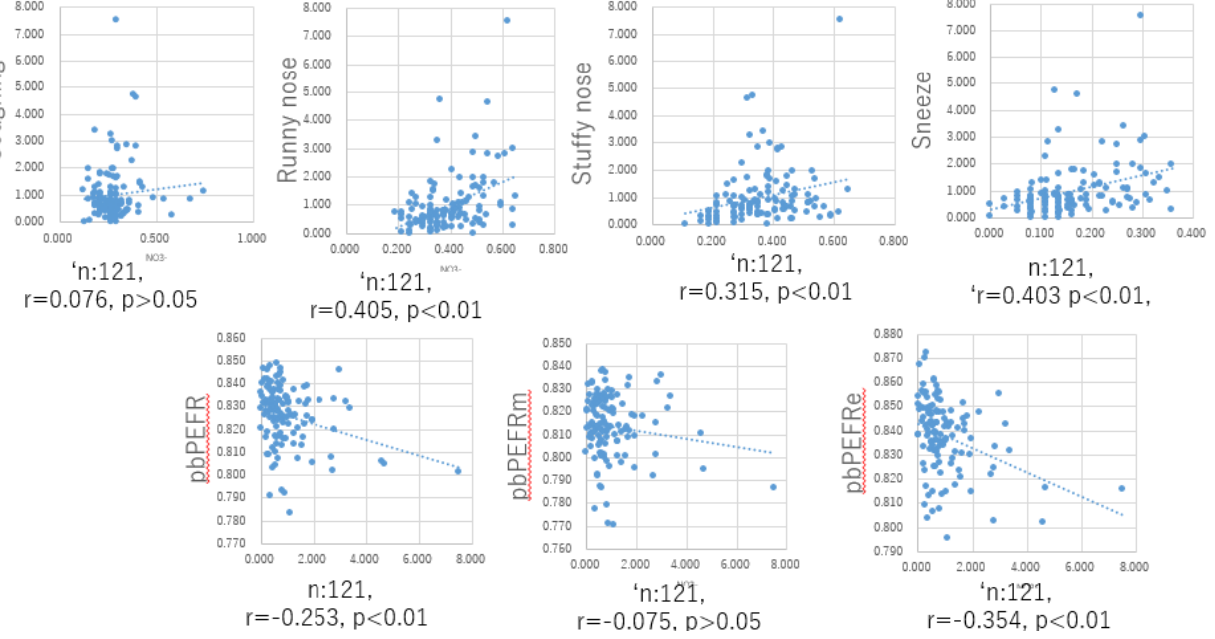
Figure 1. Scatter plot of the relationship between NO 3 − and respiratory symptoms or ratio of daily Peak Expiratory Flow Rate to personal best Peak Expiratory Flow Rate(pbPEFR), in daily mean(pbPEFR), in morning(pbPEFRm), and in the evening(pbPEFRe). Vertical axes show the number of symptoms per day in the total number of partici- pants, and horizontal axes show the daily ion concentration of NO 3- in gm −3 . Numbers are logarithmic.